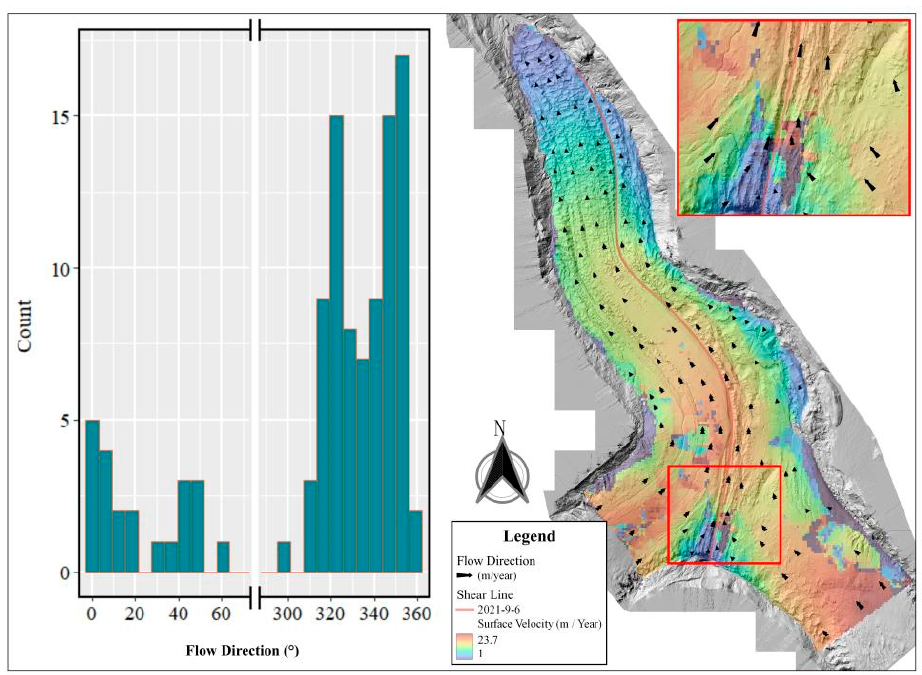
Figure 5. Surface flow direction of LHG12 detected by visual feature track, 16 July 2019–22 July 2021. The glacier’s surface velocity was obviously influenced by extrusion of the two ice flows (Figure 6). From the surface velocity extracted by three drone-based measurements in 2021, it can be seen that: the maximum annual surface velocity was 6.50 cm day − 1 (Figure